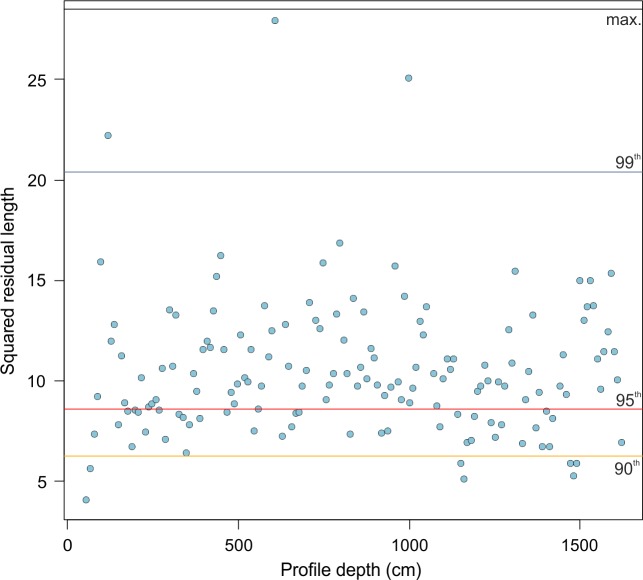
Goodness-of-fit statistics.Squared residual length of the fossil samples from the Pefka E section versus depth is shown. The 90th, 95th, and 99th percentile and the maximum residual length are indicated with lines.